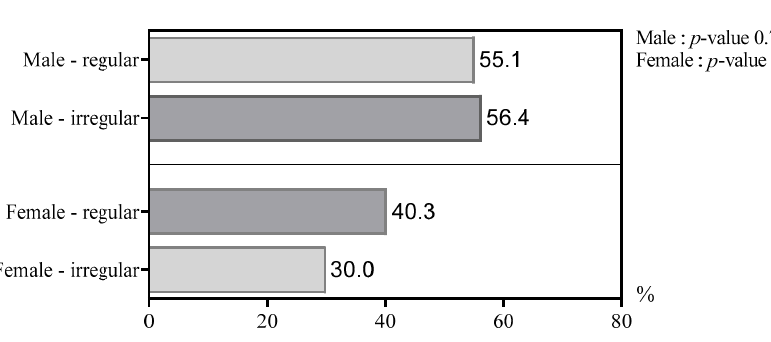
Figure 2. Periodontitis status according to gender and work pattern.